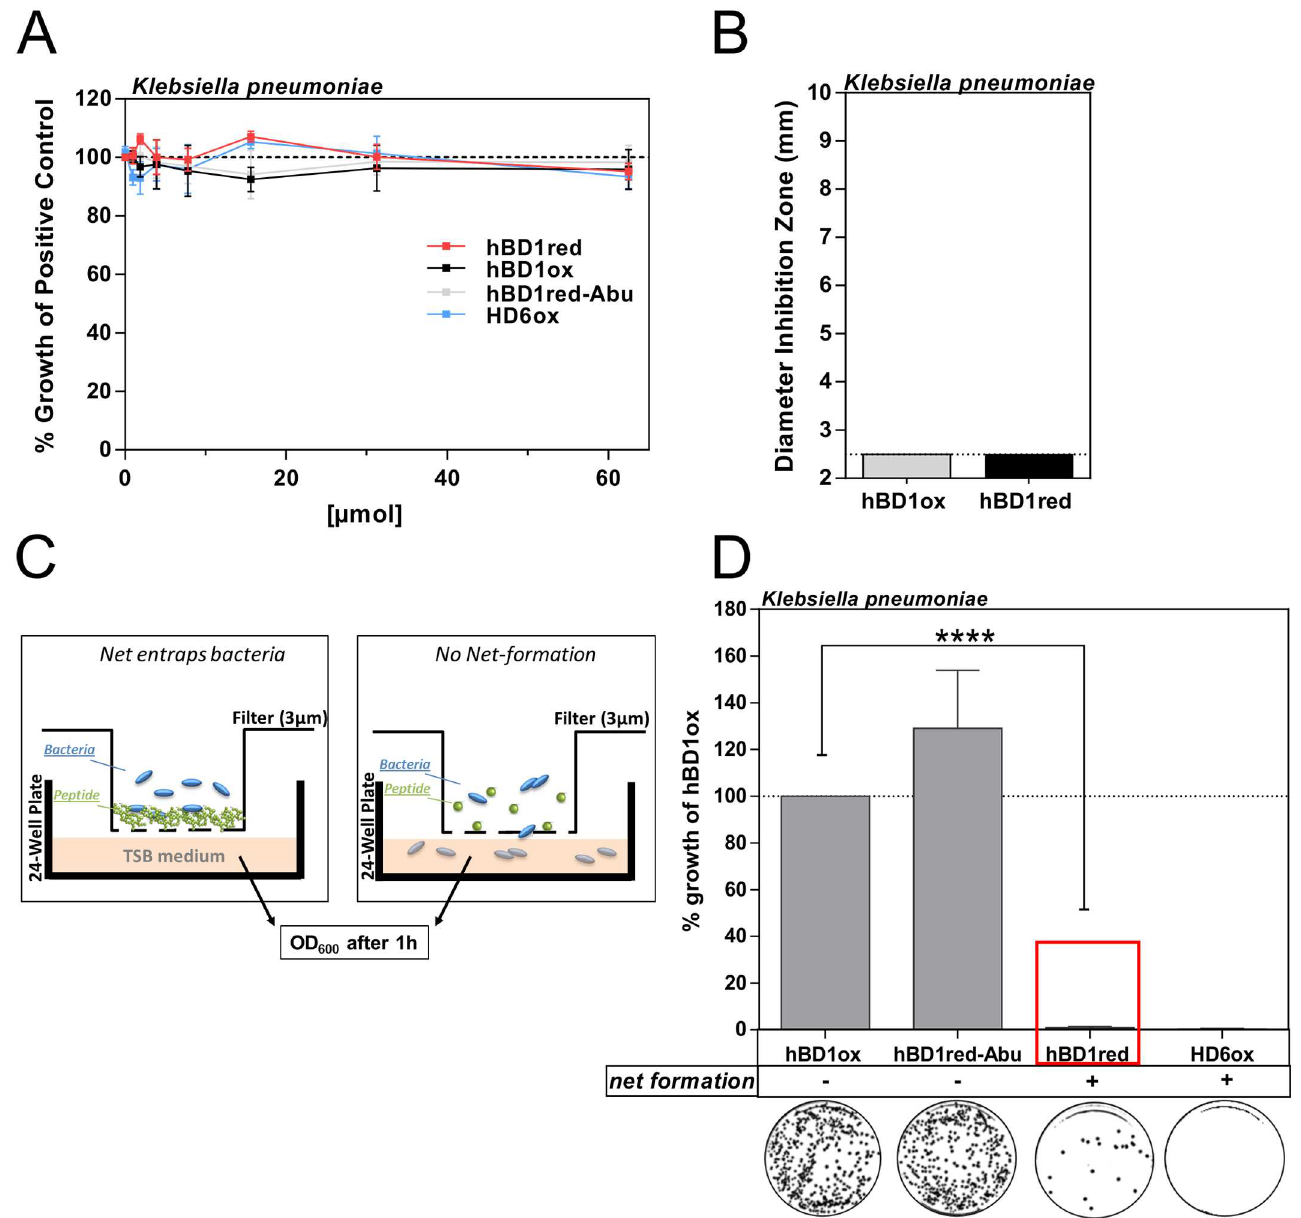
Fig 5. Proof for functional net-formation of hBD1red. Comparisonof antimicrobial activity of different hBD1 forms. Antimicrobial activity of hBD1 forms was comparedin a (A) turbidity broth assay or (B) RDA against K . pneumoniae . Different concentrations of peptideswere incubatedwith bacteria and changein optical density (OD 600 ) was measuredafter 12 h or the diameterof inhibitionzone was analyzed.HBD1 redox forms are not antimicrobial active against K . pneumoniae . (C) Schematicmodel for the TranswellMembraneAssay. Bacteria are entrappedin a net and are not able to pass the porous membrane(left), but in absence of nets bacteriapass through the membraneand grow in the TSB medium in the chamber below. (D) Bacterial growth was measuredat OD 600 after 1 h pre-incubation of peptidein filter and additional2 h and % growth of negativecontrol was plotted. With net formation no significantnumbersof bacteria are able to translocatewhich is in contrast to hBD1ox or hBD1red_Abu with no net formation. Representative blood agar plates are shown. Data are presentedas mean +/- SEM of at least three independentexperiments. The statistic was evaluatedby using student’s t-test with **** p <